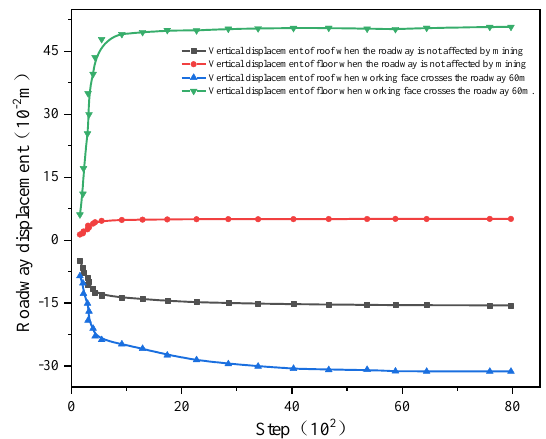
Figure 12. Vertical stress distribution of roadway surrounding rock during bolt support. ( a ) Working face is 60 m away from the roadway. ( b ) Working face is 20 m away from the roadway. (c) Working face spans the roadway 20 m. ( d ) Working face spans the roadway 60 m.